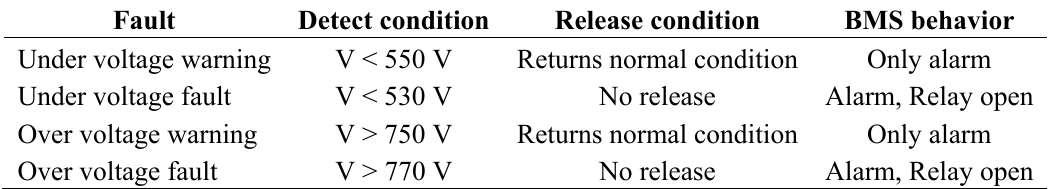
Table 1. Battery system fault